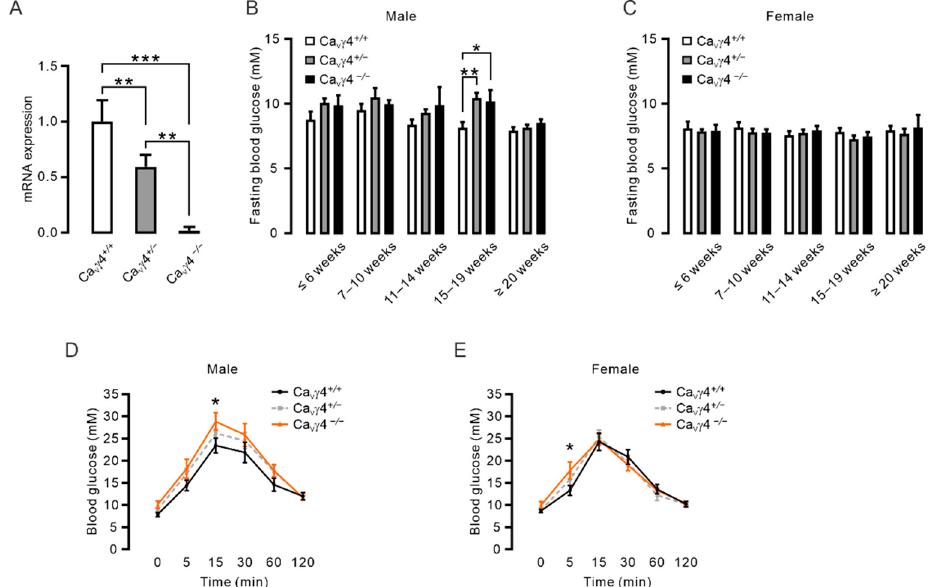
Figure 1. Impaired fasting blood glucose and glucose tolerance in Cacng4 knockout mice: ( A ) Ca V γ 4 ( Cacng4 ) mRNA levels in isolated islets from wild type ( Ca V γ 4 +/+ ), heterozygous ( Ca V γ 4 +/ − ), and homozygous ( Ca V γ 4 − / − ) Cacng4 knockout mice, n = 3, 4 and 3 mice, respectively. *** p < 0.001 ( Ca V γ 4 +/+ vs. Ca V γ 4 − / − ) and ** p < 0.01 ( Ca V γ 4 +/+ vs. Ca V γ 4 +/ − and Ca V γ 4 +/ − vs. Ca V γ 4 − / − ). ( B ) Blood glucose levels in